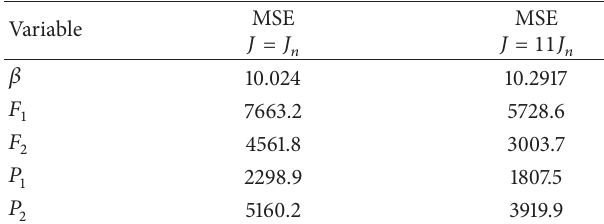
Table 3: Results of all the tests for given moments of inertia, calculated as mean squared error between both the actuator and the model response ( 𝛽 is joint angle [deg], 𝑃 1 is left muscle relative pressure [kPa], 𝑃 2 is right muscle relative pressure, 𝐹 1 is left muscle force [N], and 𝐹 2 is right muscle force